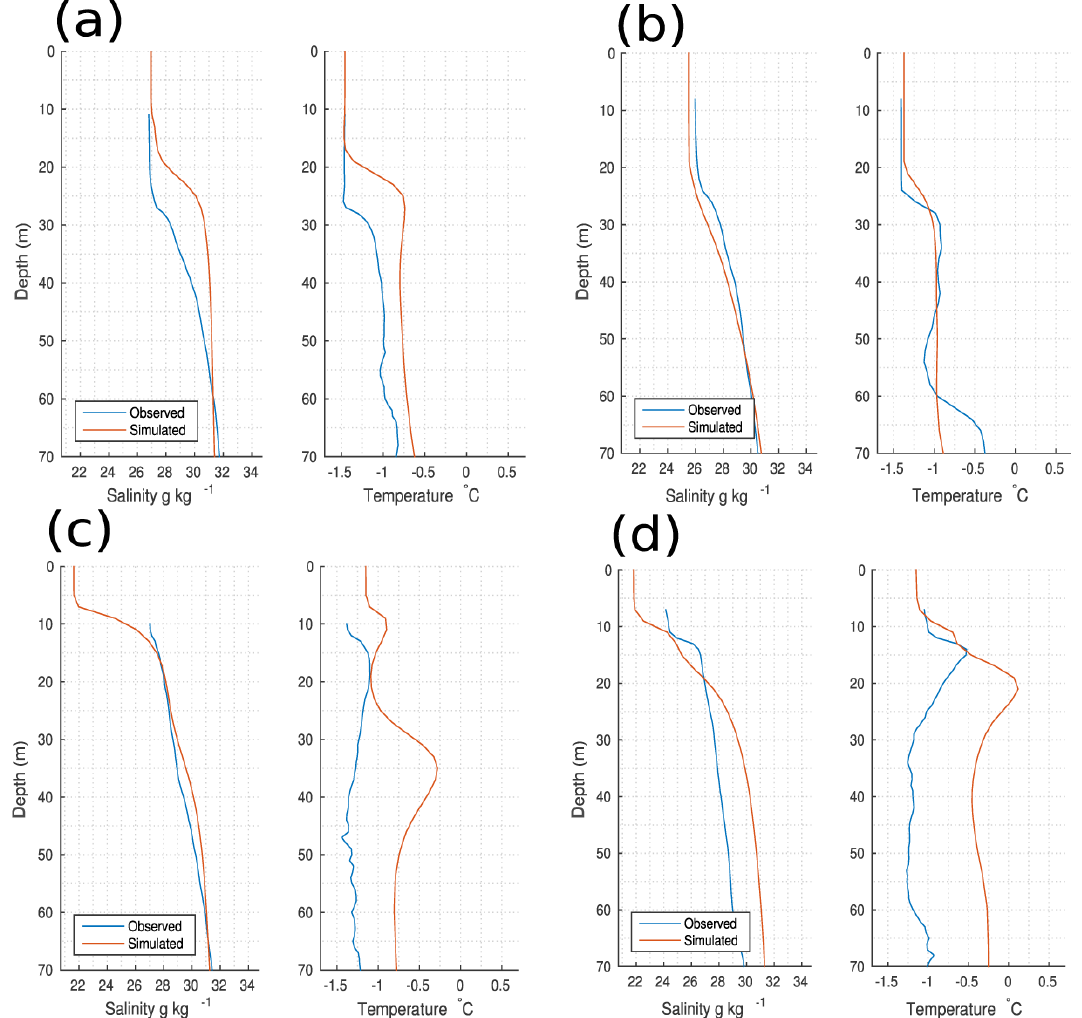
Figure 5. Salinity and temperature of the top 70m based on ITPs and A1. (a) ITP 1 on 13 December 2006 at 74.80 ◦ N and 131.44 ◦ W. (b) ITP-43 on 27 November 2010 at 75.41 ◦ N and 143.09 ◦ W. (c) ITP 1 on 28 August 2006 at 76.96 ◦ N and 133.32 ◦ W. (d) ITP-13 on 30 July 2008 at 75.00 ◦ N and 132.78 ◦